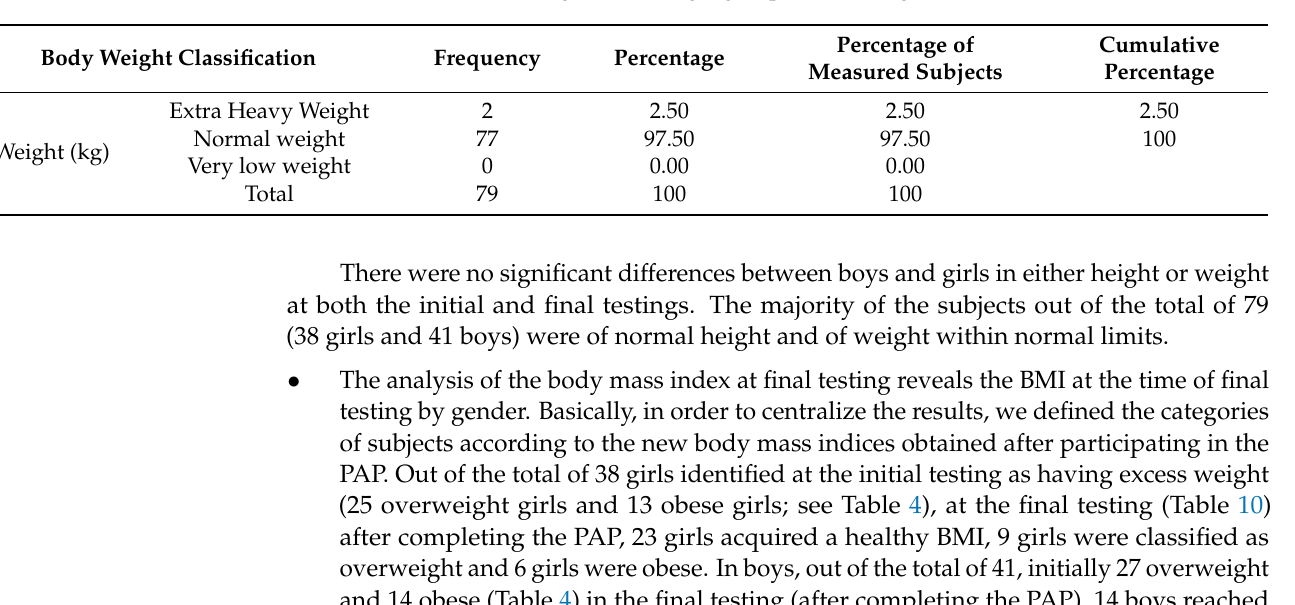
Table 9. Distribution of weight in the target group–final